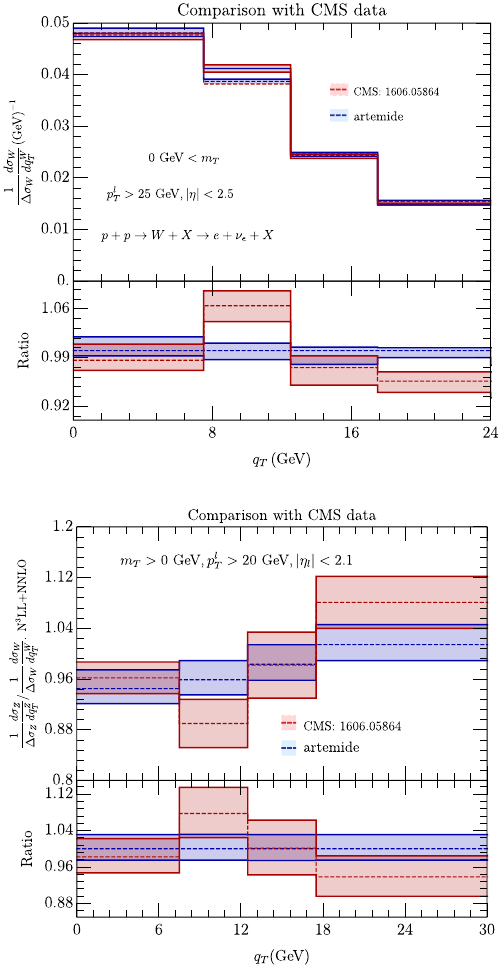
√ s = 1 . 96 TeV [12] and with CDF experiment at √